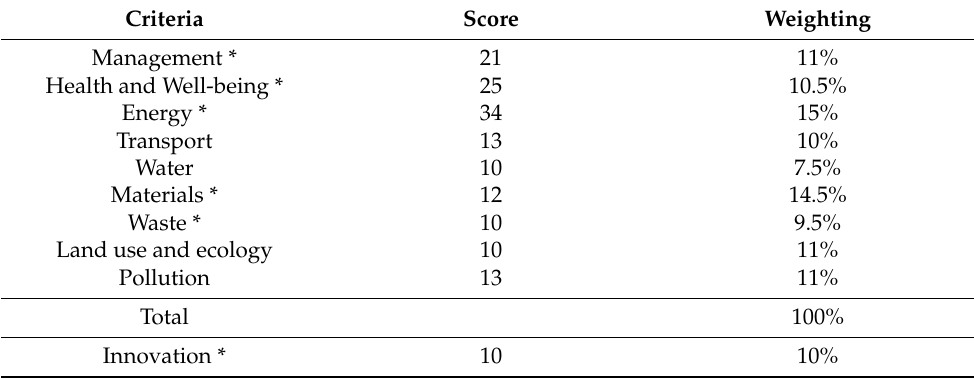
Table 1. Criteria of BREEAM INC